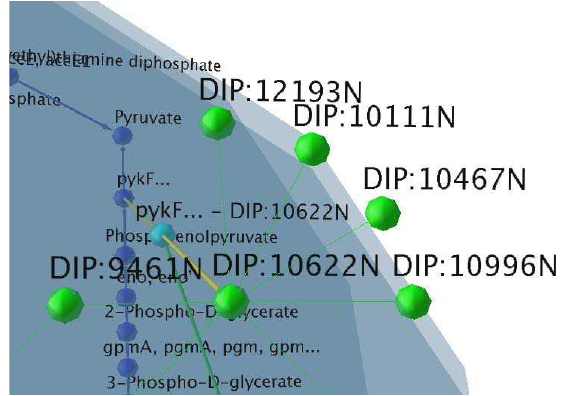
Figure 3: The protein DIP:10622N in the protein interaction network is identical to the enzyme pykF in the metabolic network. It interacts with several other proteins. See the text for a discus-